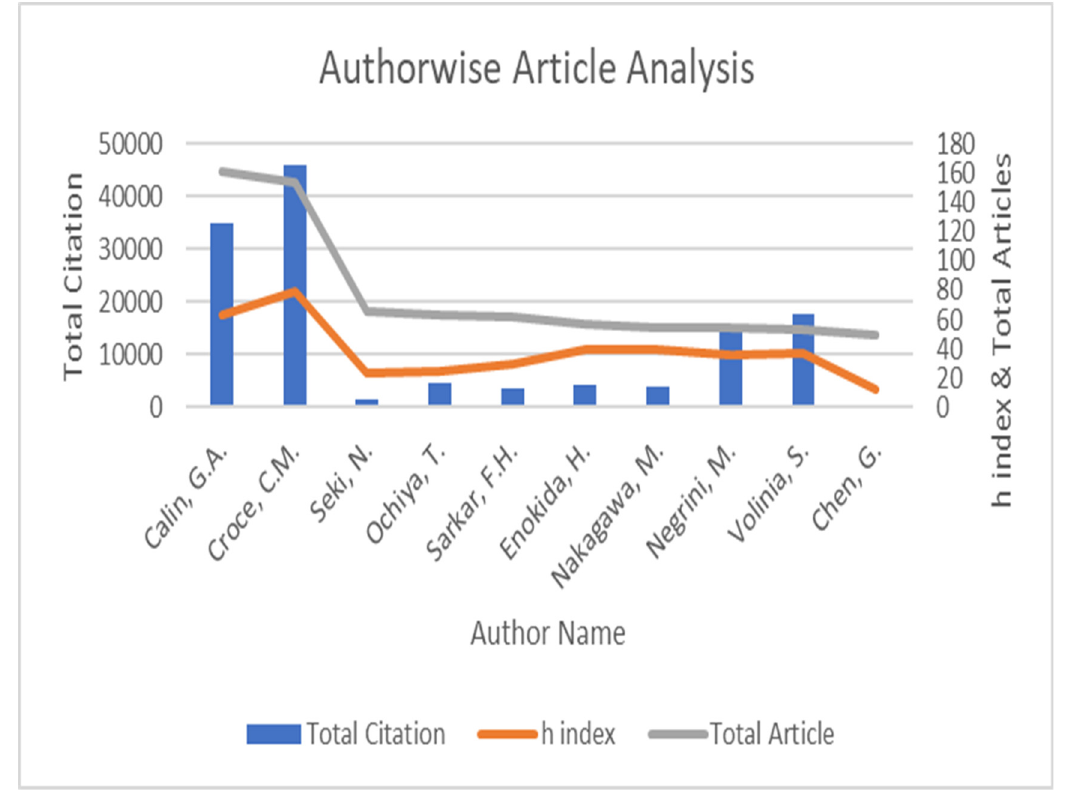
Figure 4. Author wise article analysis. Table 5. Top 10 authors publishing on miRNA in